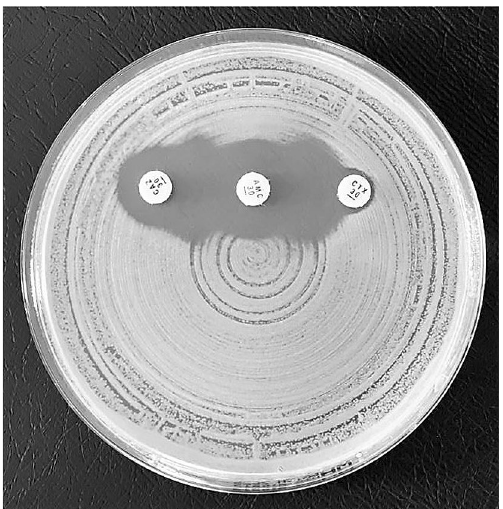
Figure 1. Image showing double-disk diffusion method (photo by Nahid